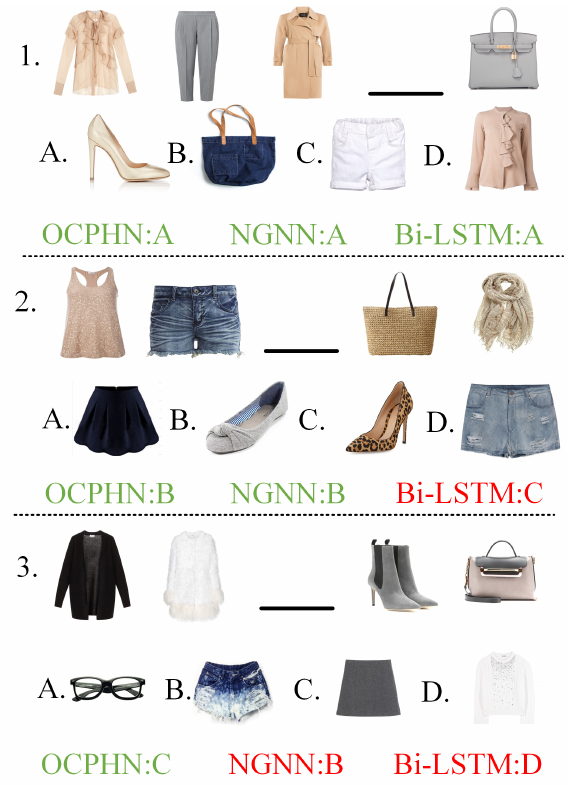
Figure 5. Comparison of our model and two baselines (i.e., NGNN and Bi-LSTM) for fill-in-the-blank task. Green font represents the right answer, and red font represents the wrong